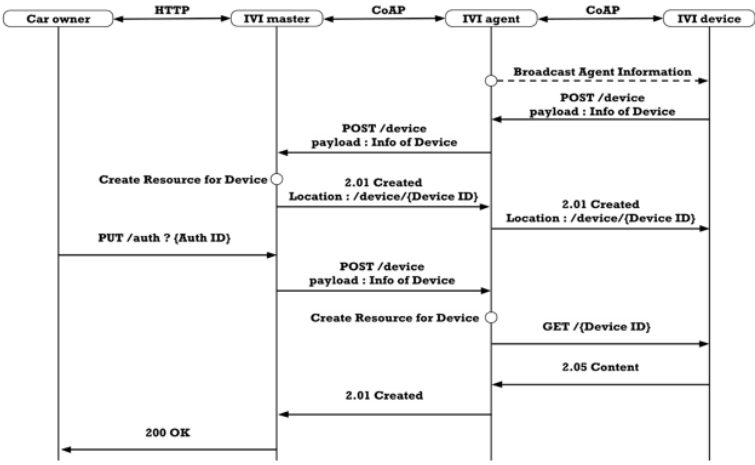
Figure 11. Operation flows for IVI device registration.